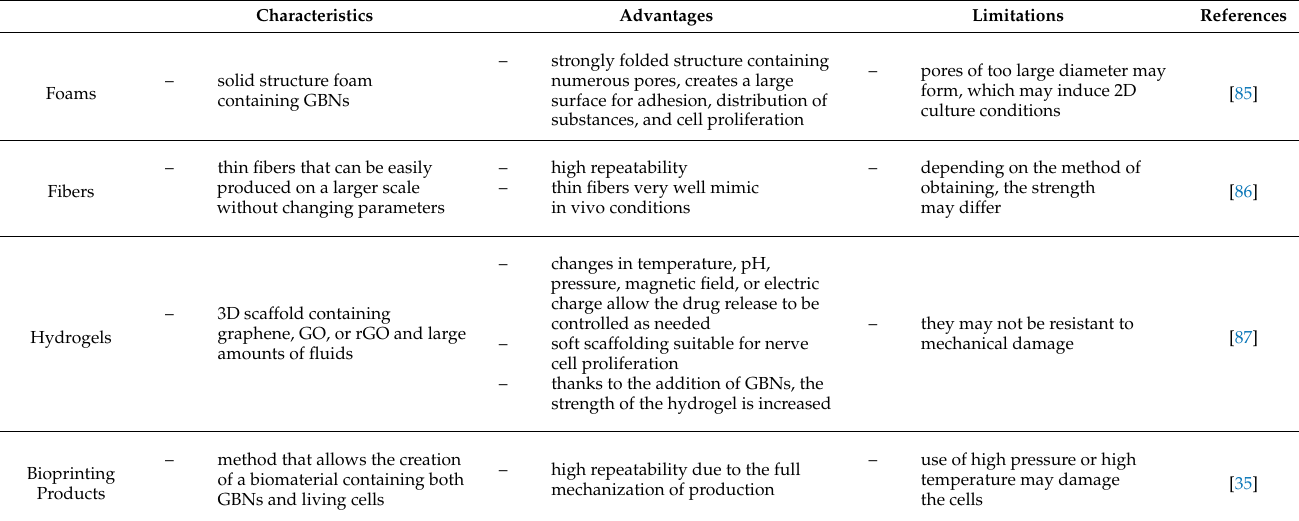
Table 8. Compilation of 3D graphene-based